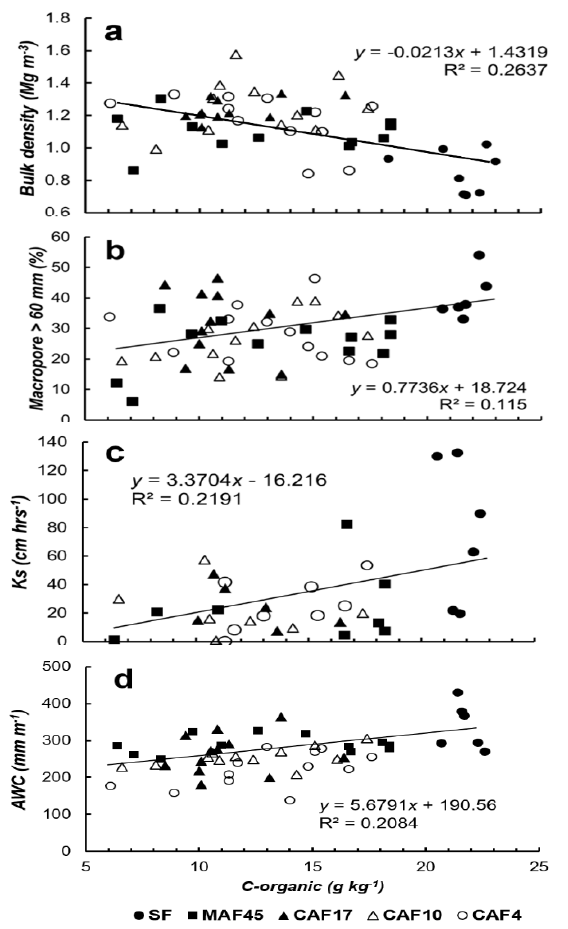
Figure 7. Surface soil bulk density ( a ), macro–porosity as percentage of total soil pores ( b ), saturated hydraulic conductivity – Ks ( c ) and available water capacity – AWC, expressed in mm of water per meter of soil ( d ) as related to soil organic matter measured at different cocoa–based agroforestry systems, i.e., secondary forest (SF), cocoa agroforestry that is 4–5 years old (CAF4), 10–12 years old (CAF10), and 17–34 years old (CAF17) and multistrata agroforest that is 45–68 years old (MAF45).